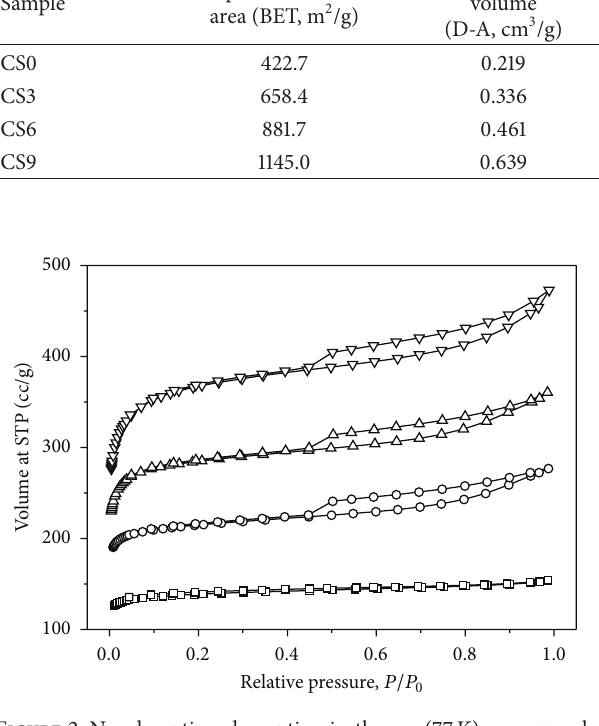
Figure 2: N 2 adsorption-desorption isotherms (77K) correspond- ing to the four samples. ◻ : CS0; I : CS3; △ : CS6; and 󳶚 : CS9.